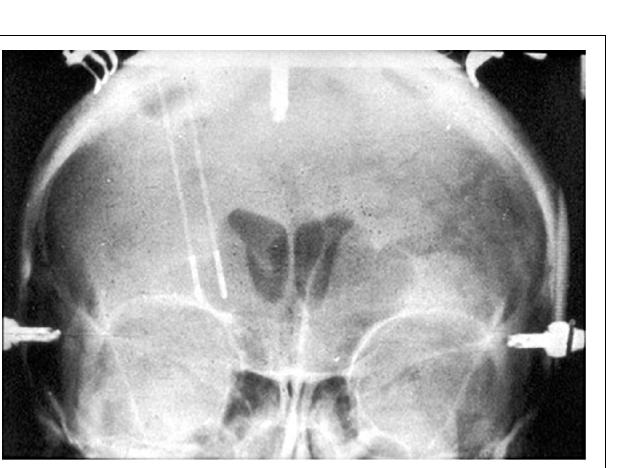
FIGURE 2 | Coronal X-ray of electrodes in place for creation of Leksell’s right frontal capsulotomy